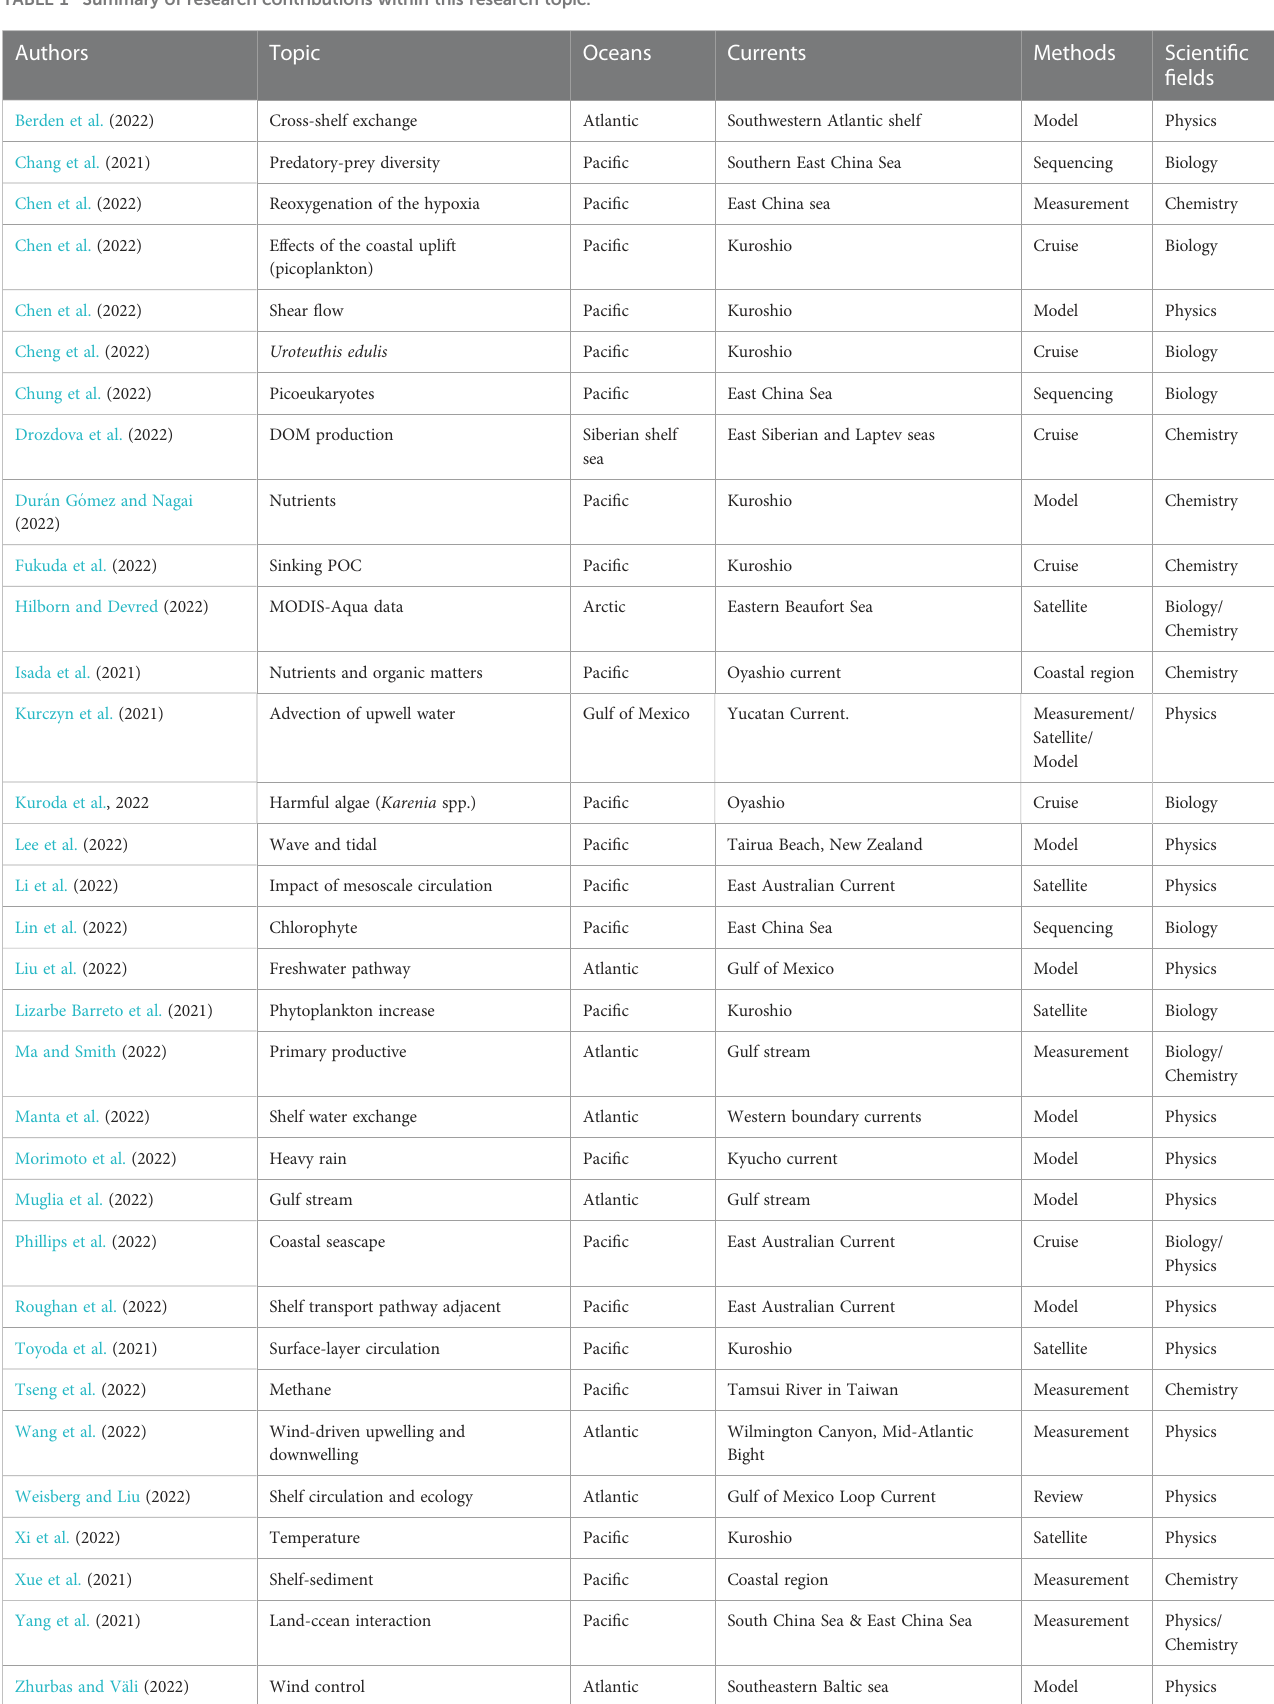
TABLE 1 Summary of research contributions within this research